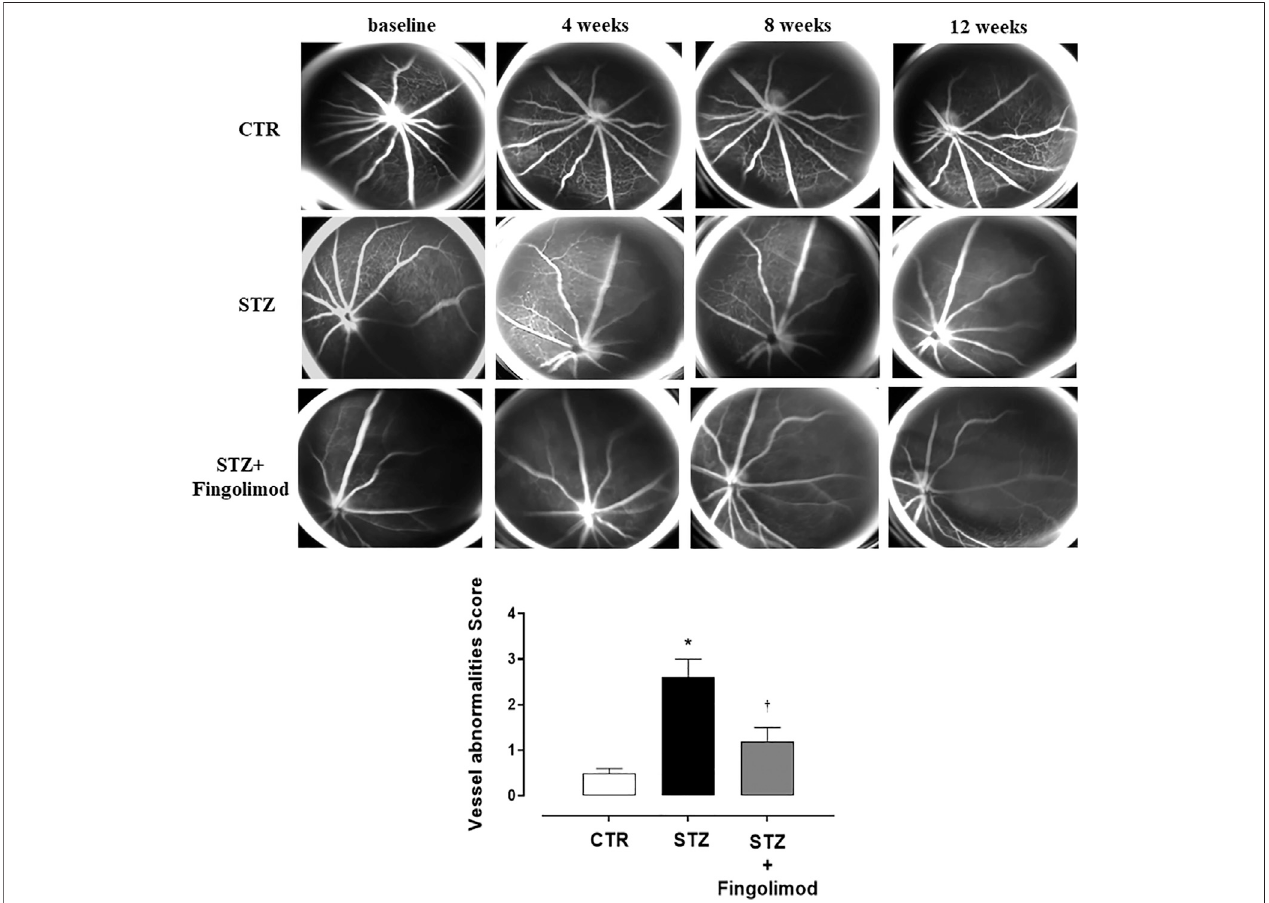
FIGURE1| RepresentativeFAimagesofeyesofnon-diabeticmice(CTR),diabeticmice(STZ),anddiabeticmicetreatedwithFingolimod(STZ+Fingolimod)duringthe follow-up.InCTR miceno changesinretinalvascularity werenoticed duringfollow-up.Instead,inSTZ mice,therewasanincreaseintheirregularityofthevesselsize,which beganat4 weeksand lookedappearedmoreevidentat8 weeks,inwhichapatternofthe “ rosary-like ” vesselwasappreciated(redarrow).At12 weekstherewasafurther thinning of the vascular caliber. In the STZ + Fingolimod group, no signi fi cant changes in retinal vascularity were seen during follow-up. Vessel abnormalities score (gradedfrom0to4)wascalculatedastheaverageofthevascularalterationsobserved(N (cid:1) 5animalspergroup).Vesselabnormalitiesweregradedfrom0to4basedonthe presence of vessel thinning, tortuosity, venous beading, and rosary-like vessels. Each image represents the same retina of the same mouse but at different time points (at baseline, 4 – 12 weeks of treatment). Statistical signi fi cance was assessed by one-way ANOVA, followed by Tukey ’ s multiple comparison test. * p < 0.05 vs CTR; † p < 0.05 vs STZ.